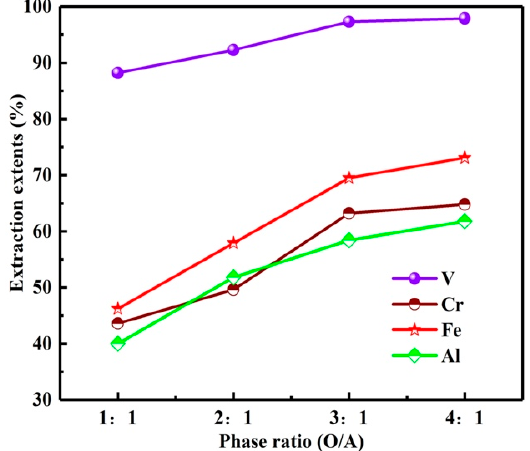
Figure 13. Influence of O/A on extraction extents.